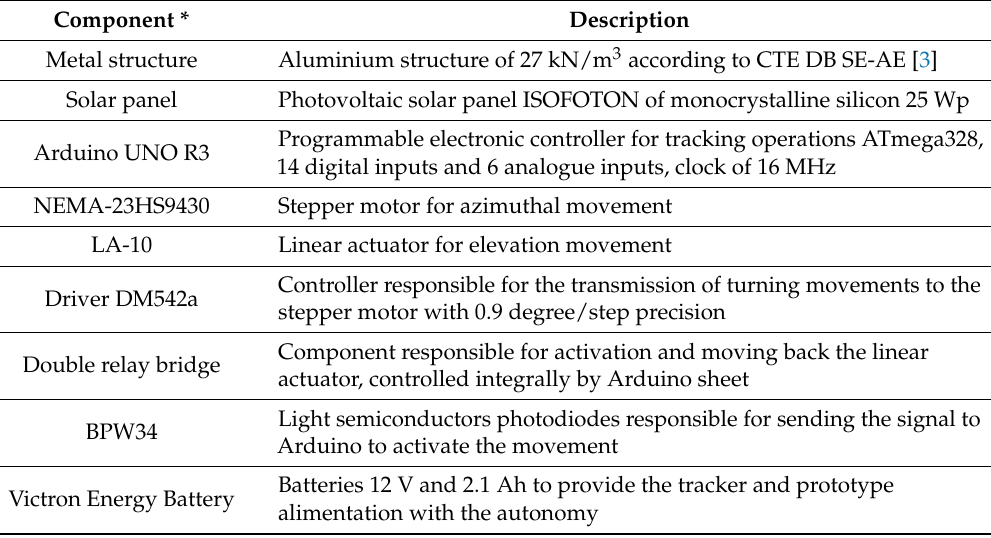
Table 1. Short description of prototype’s components.